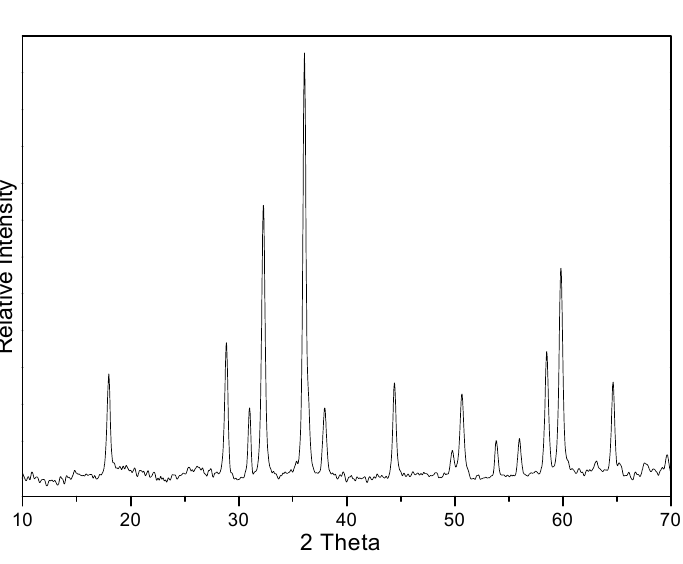
Fig. 1 XRD Pattern of product after heating.